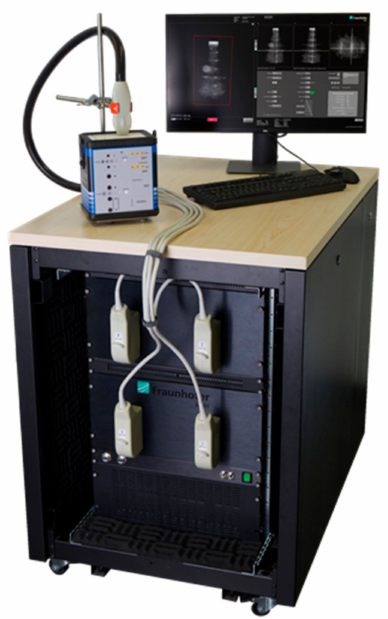
Figure 8. Fully integrated 1024 CH